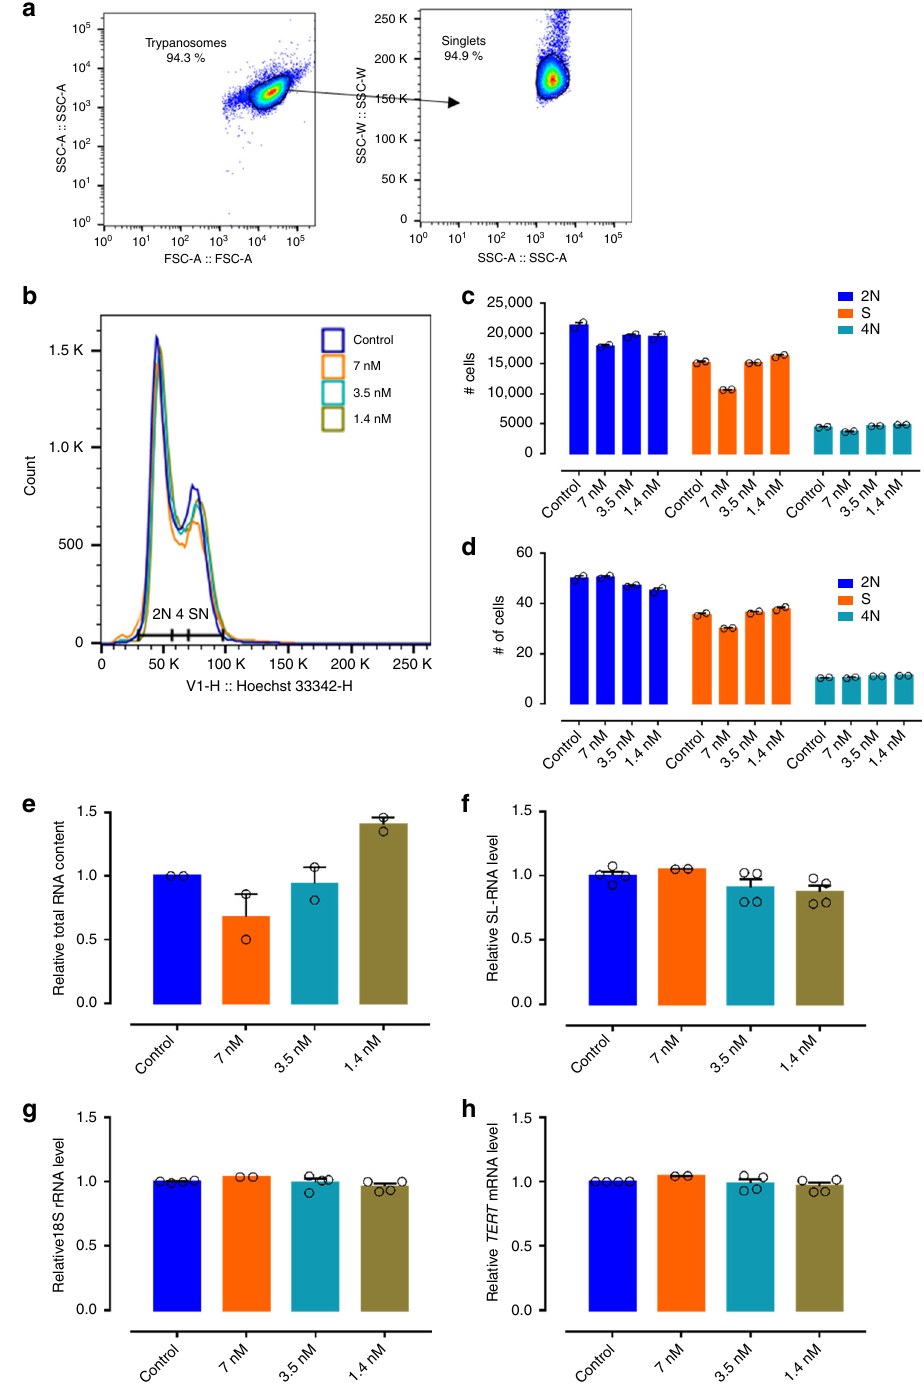
Fig. 7 Evaluation of the effect of 9 on cell cycle regulation and RNA synthesis. a Gating strategy. b Results of the cell cycle analysis at different concentrations of compound 9 . Results of the cell cycle analysis (2 N , S phase, 4 N ) expressed in total cell numbers ( c , n = 2) and relative cell numbers ( d , n = 2). e Total RNA yield from trypanosomes exposed to different concentrations of compound 9 ( n = 2). RNA content quanti fi ed using RT-qPCR speci fi cally targeting SL-RNA ( f , n = 2 with two replicates), 18S rRNA ( g , n = 2 with two replicates) and TERT mRNA ( h , n = 2 with two replicates). RNA content and transcript levels are expressed as relative to the non-treated trypanosomes (control). Error bars are SEM. Source data are provided as a Source Data fi